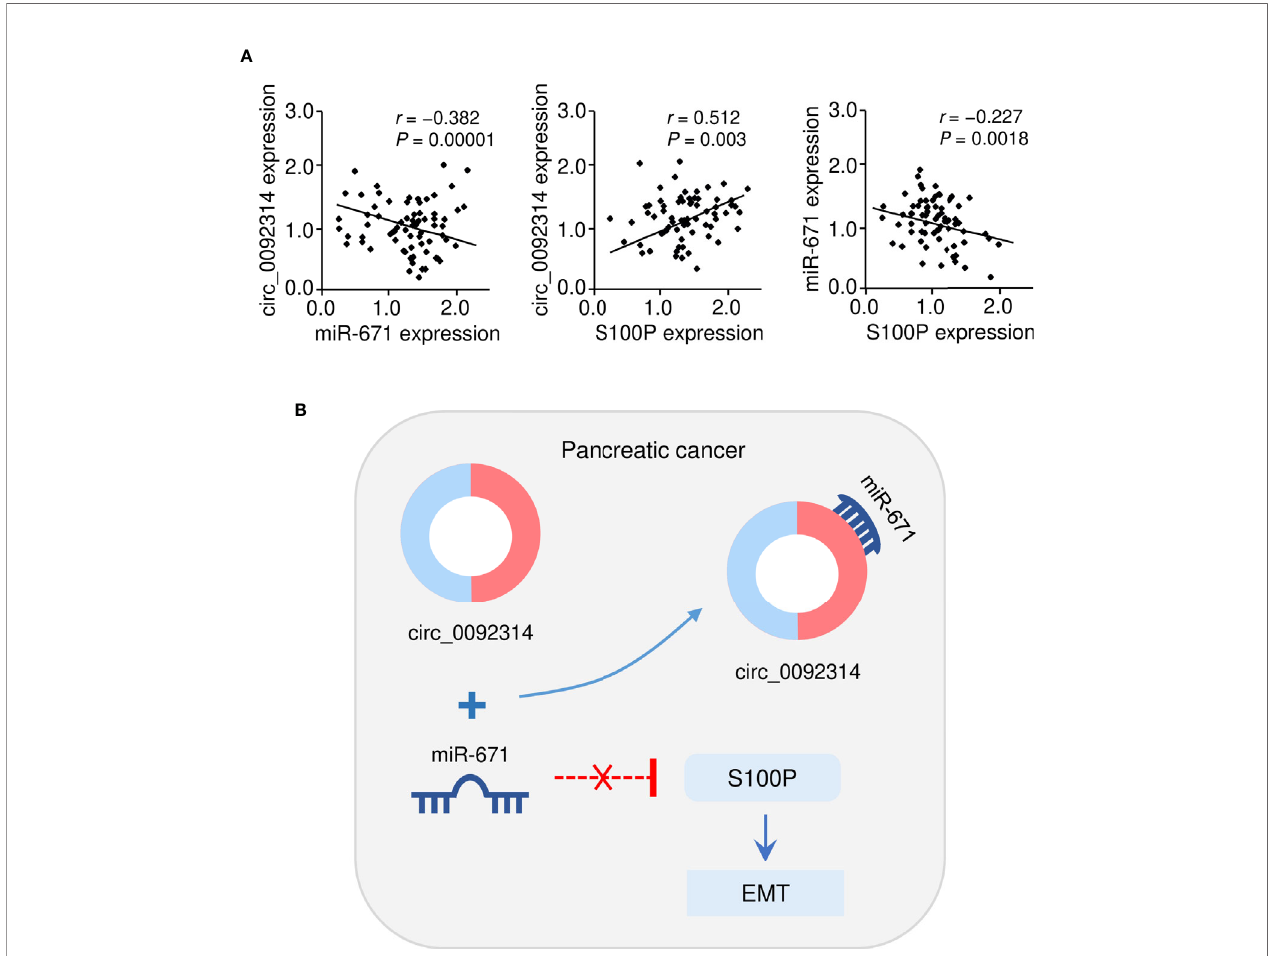
FIGURE 8 | The correlation between circ_0092314 and miR-671/S100P expression in PAAD tissues. (A) The correlation between circ_0092314 expression and miR-671/S100P expression in PAAD tissues was examined using qRT-PCR assay. (B) A proposed mechanistic model in which circ_0092314 can sponge miR-671 to increase S100P expression, thereby promoting EMT and PAAD cell